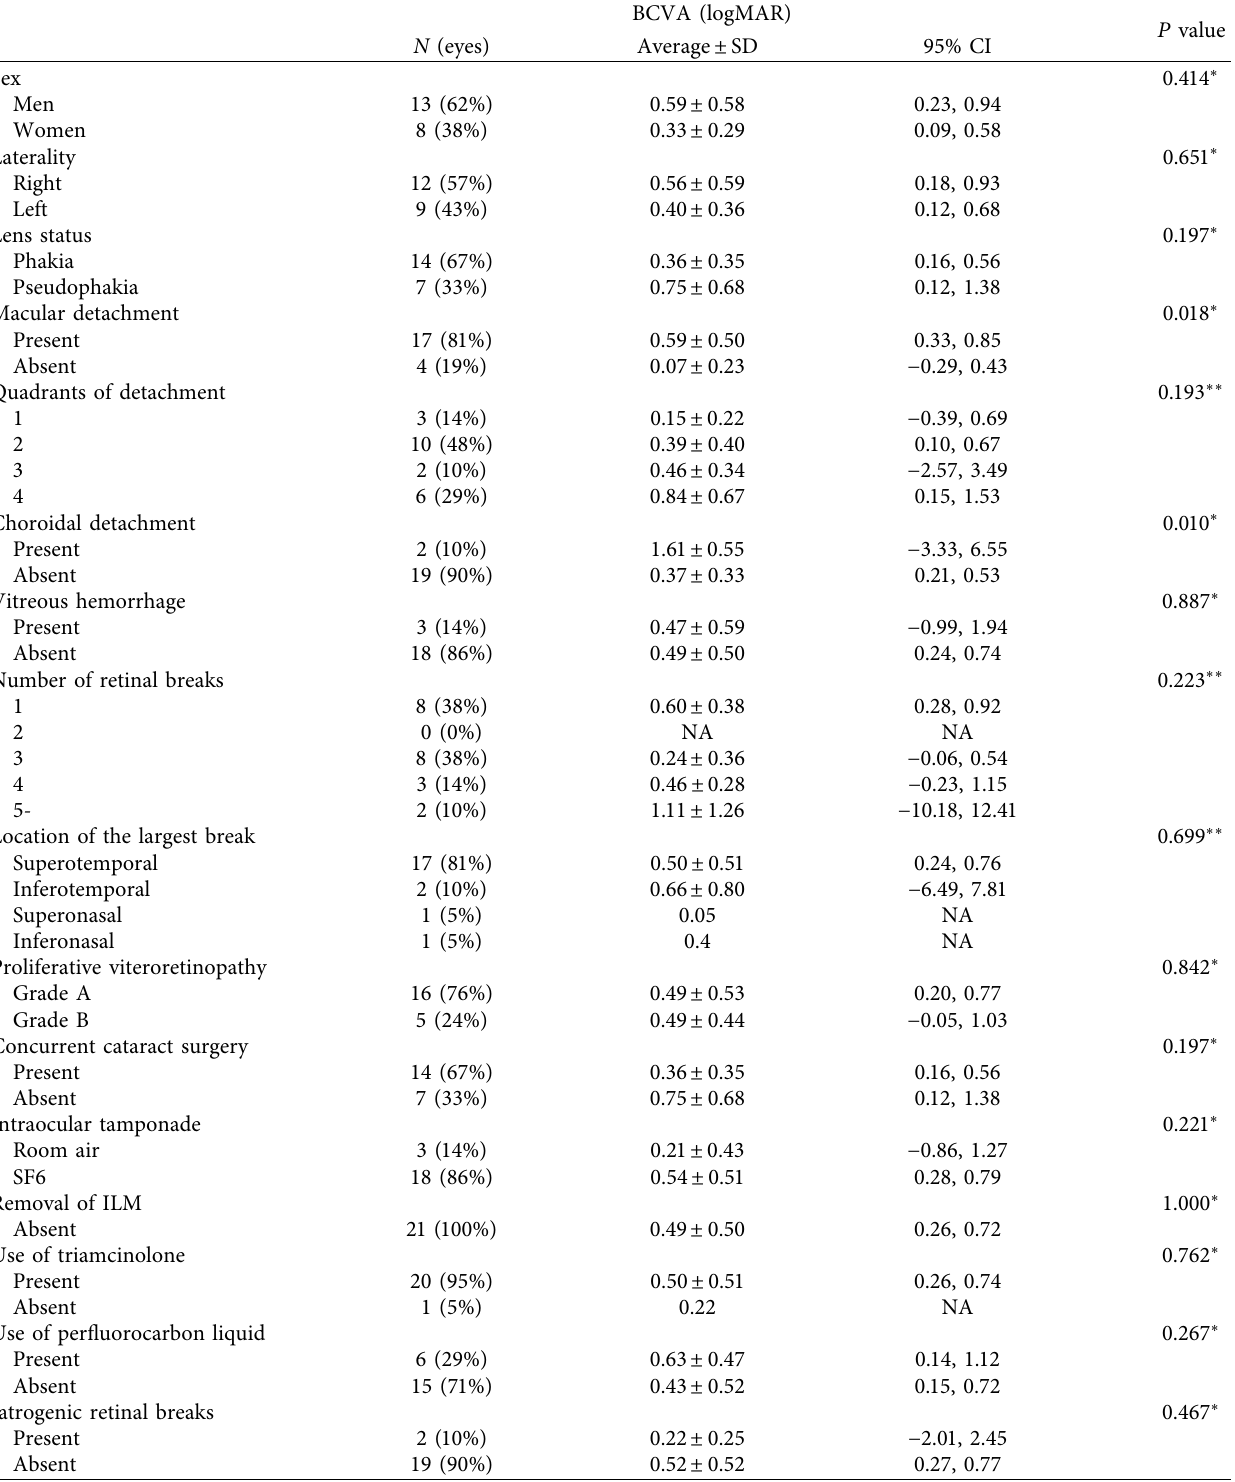
Table 1: Relationship between factors before initial surgery and the final visual